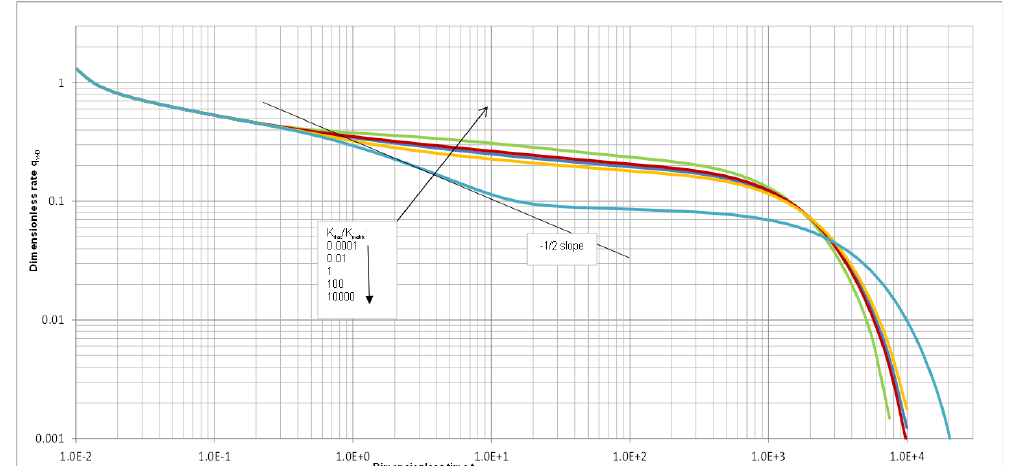
Figure 10. Rate behaviors of the well with respect to different permeability ratios of natural fracture to formation, W D = 50, H D = 50, w fD = 0.01, 2 L fD = 10, and X vD = 2.